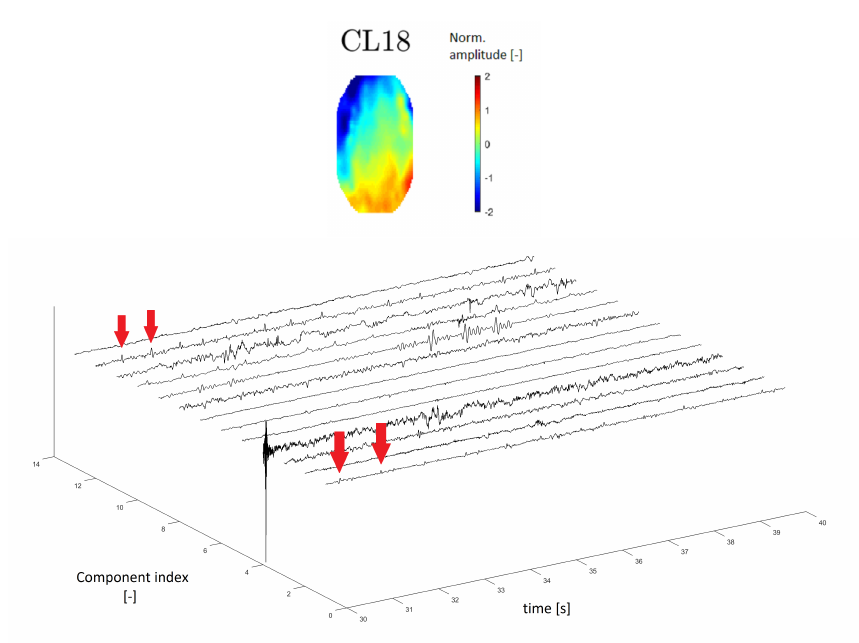
Figure 12. Topomap of cluster CL18 representing an electrocardiographic (ECG) artifact ( top ). Time-series graphs of a 10-second section of the signal clustered into the same cluster by IC topomaps. The arrows indicate an example of the ECG peak residuum, which manifested in the time-series graphs.